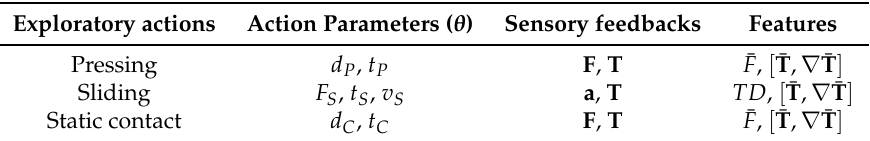
Table 2. Exploratory actions and